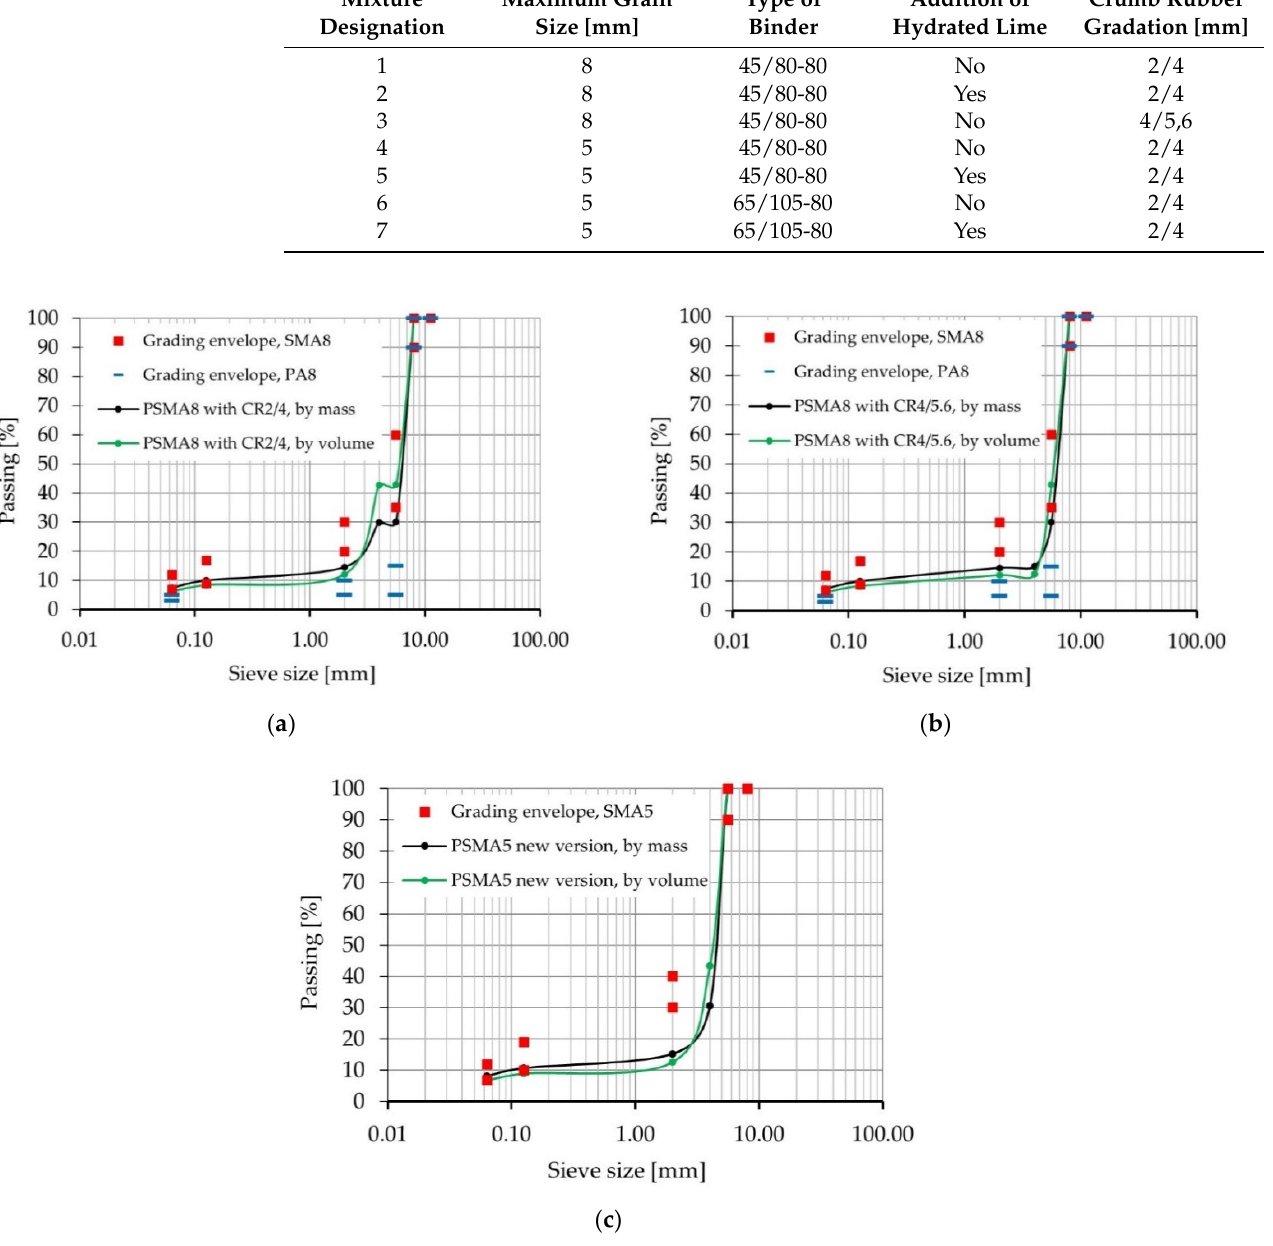
Figure 1. Gradation curves: ( a ) PSMA 8 CR 2/4, ( b ) PSMA 8 CR 4/5.6, ( c ) PSMA 5 CR 2/4.